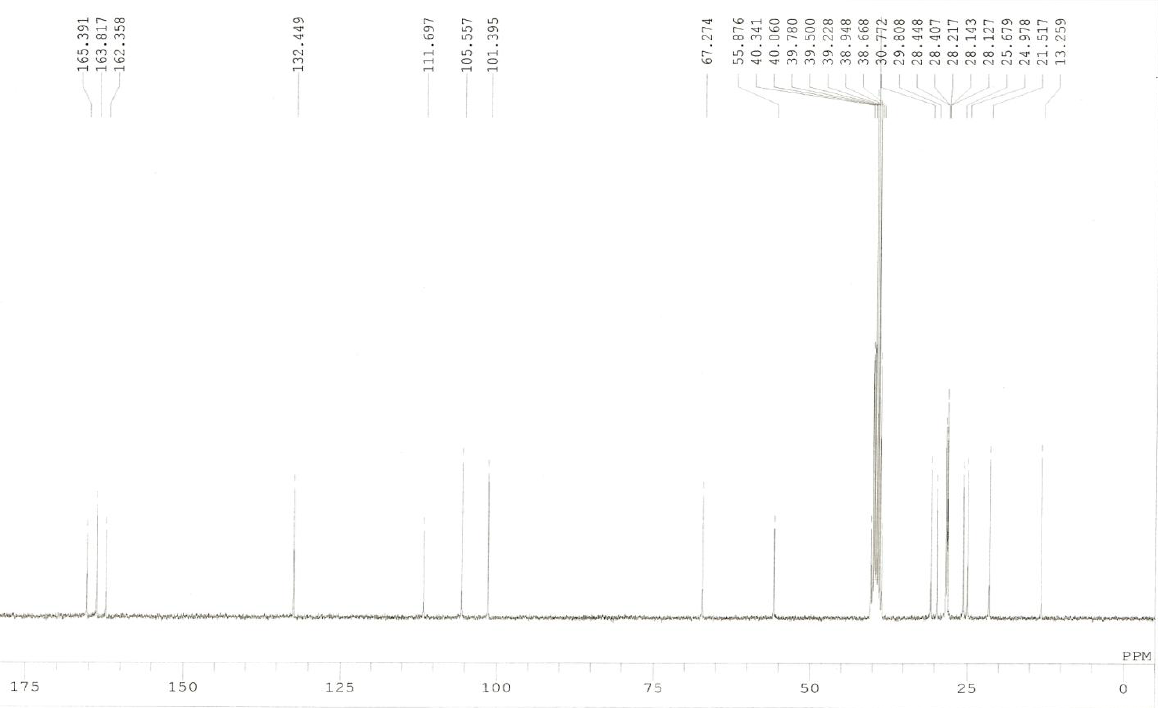
Fig. S2 – 13 C{ 1 H} NMR Spectrum of ligand, H